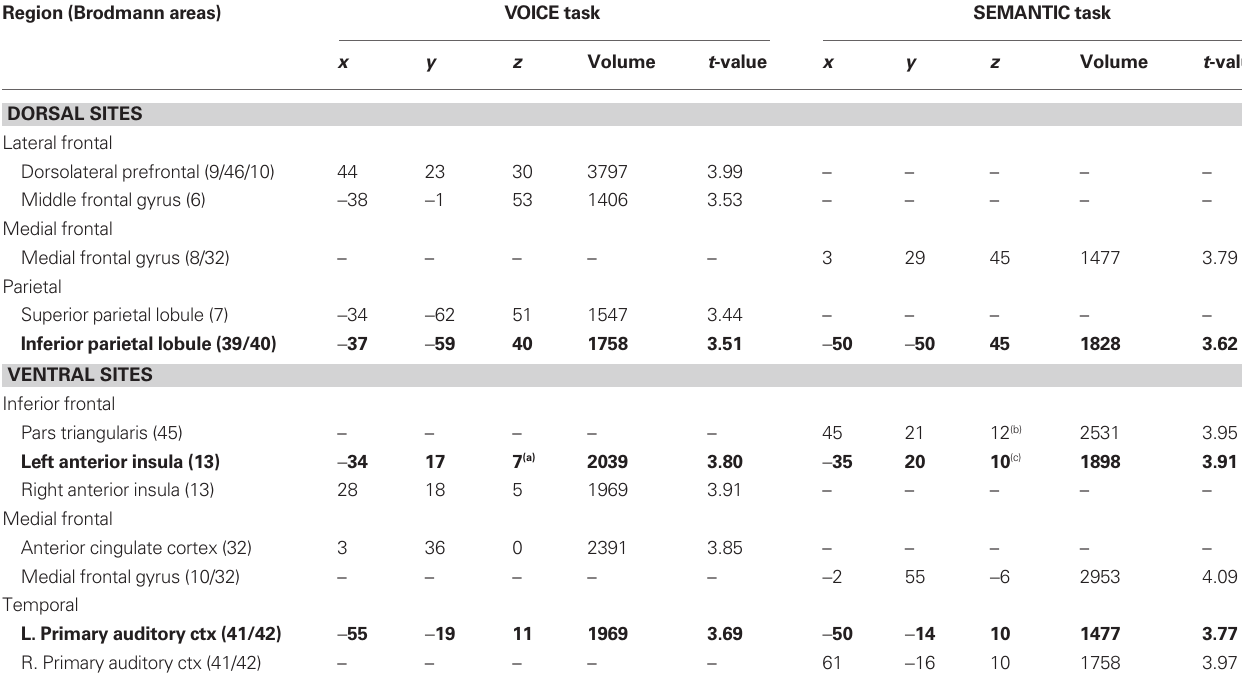
Table 1 | Brain regions, peak Talairach coordinates and volumes of activated clusters showing main effects of attentive listening in the two auditory Stroop